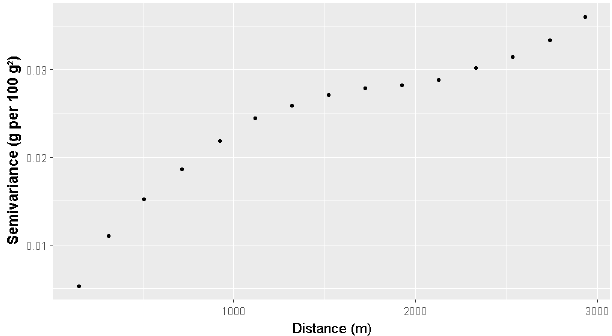
Figure 2. Block support experimental variogram of the coarse-scale (100m resolution) soil carbon